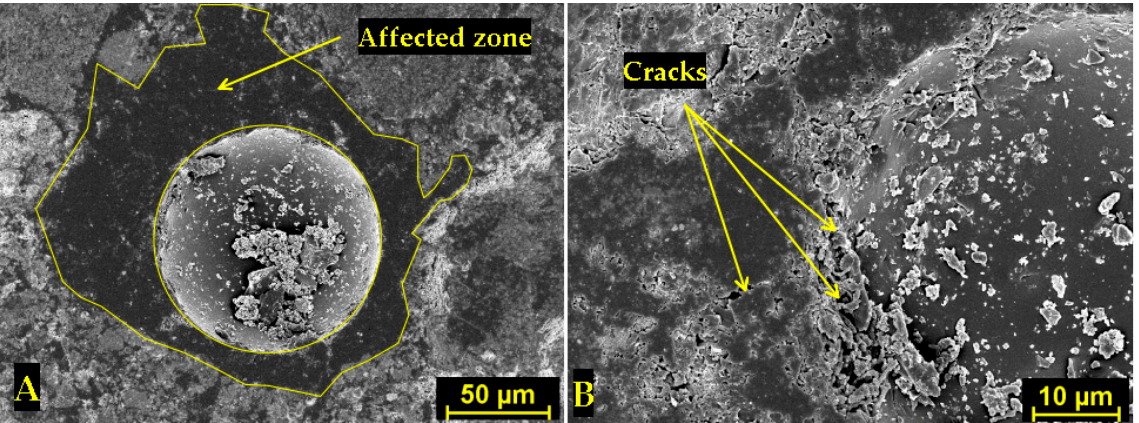
Figure 2. SEM image of the affected zone around the SAP core in hardened C1.5 mixture ( A ) and microcrack formation in ITZ ( B ).